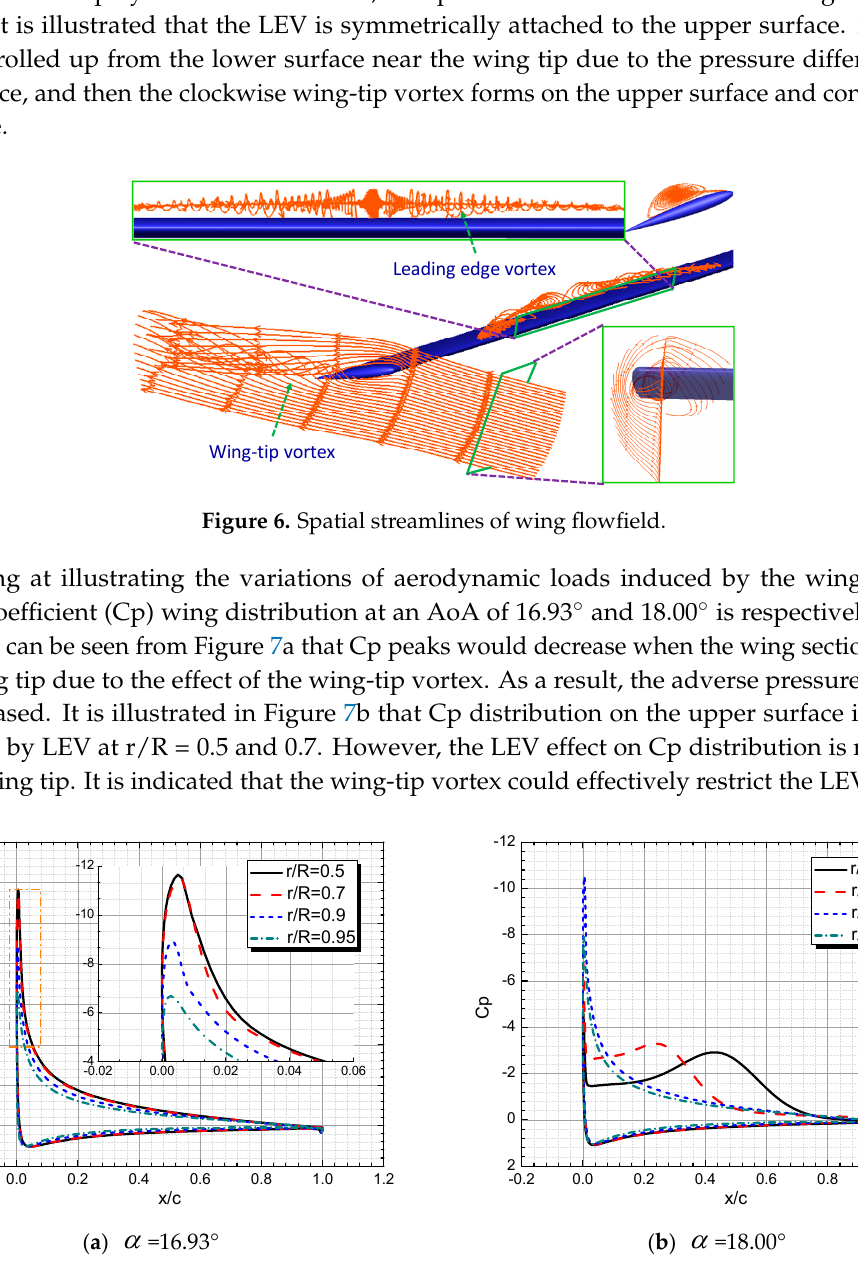
Figure 5. Finite-wing vorticity at different wing sections ( α = 16.93 ◦ ). Figure 5. Finite ‐ wing vorticity at different wing sections ( 16.93 o  ). Figure 5. Finite ‐ wing vorticity at different wing sections ( 16.93 o  ). Figure 5. Finite ‐ wing vorticity at different wing sections ( 16.93 o  ).